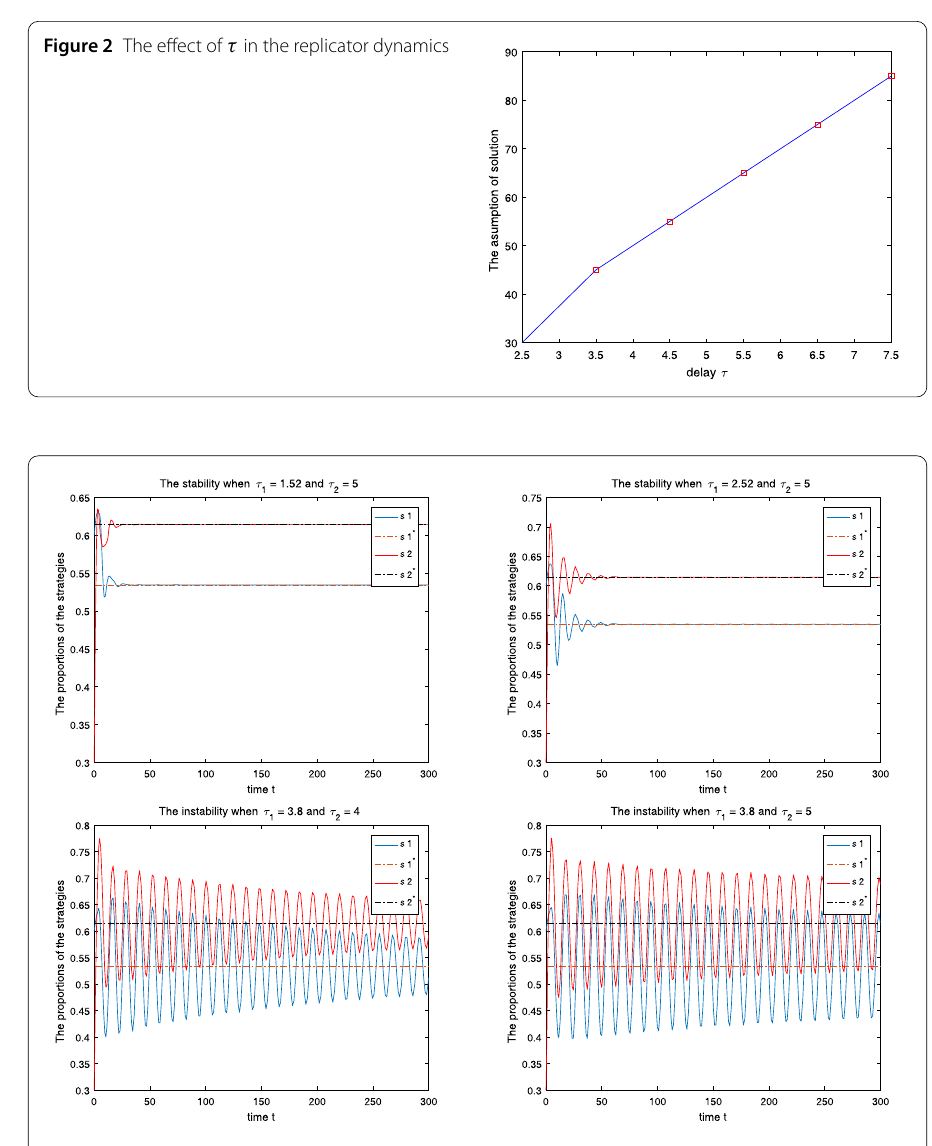
Figure 3 The stability and instability of the mixed NSS with two